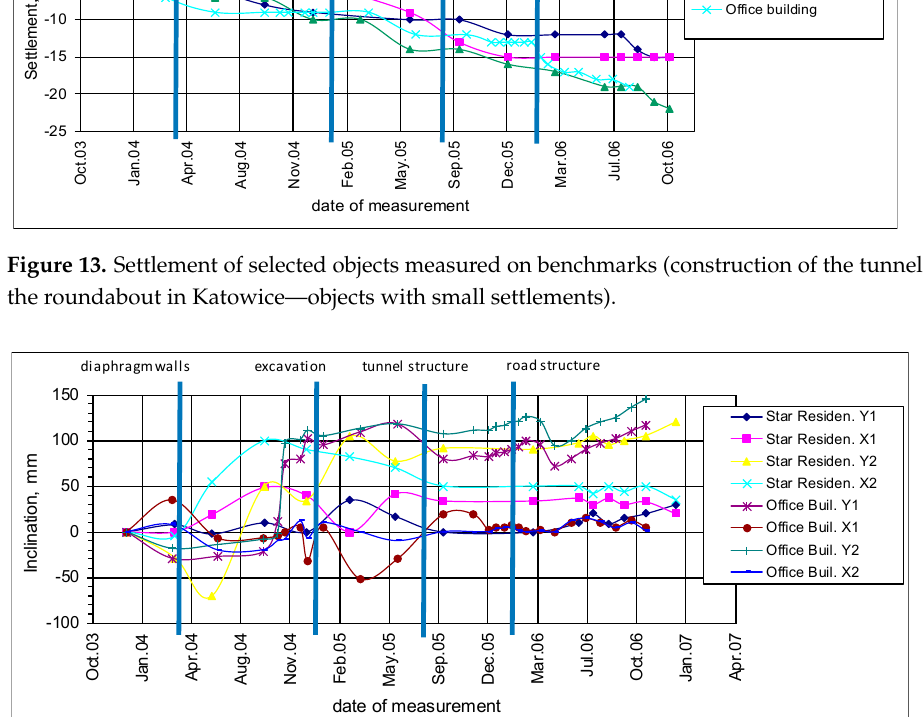
Figure 14. Inclination of selected objects (construction of the tunnel under the roundabout in Katowice—objects with significant inclinations).